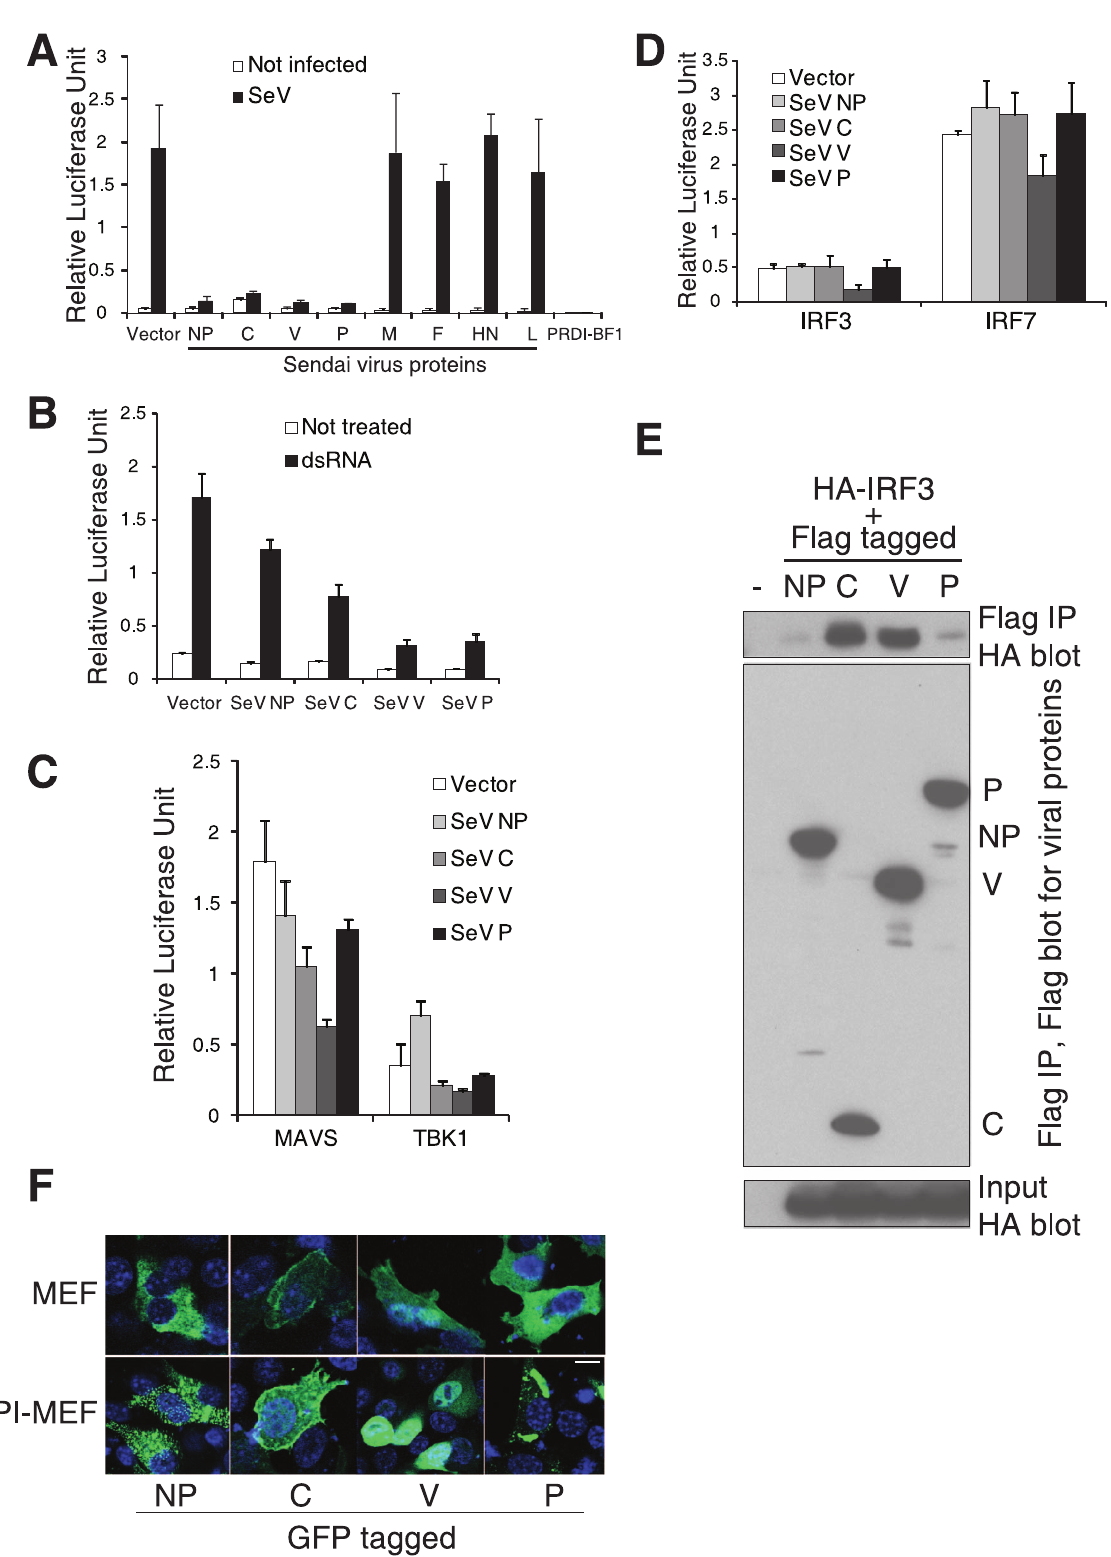
Figure 6. SeV encoded proteins inhibit IFN b expression. A . NP, C, V and P proteins inhibit IFN b reporter induction by SeV. Expression constructs for SeV proteins were cotransfected into 293T cells with an IFN b promoter driving firefly luciferase expression plasmid together with a renilla luciferase reporter. 24 hrs later the cells were infected with SeV and luciferase activities measured after an additional 24 hrs.The PRDI-BF1 expression construct was also transfected as a control. B . SeV C, V and P proteins suppress IFN b induction by dsRNA (poly I:C). Experiments were conducted as in A, but dsRNA (2 m g/ml) was used instead of SeV to induce IFN b expression. C . MAVS and TBK1 induced IFN b expression is strongly